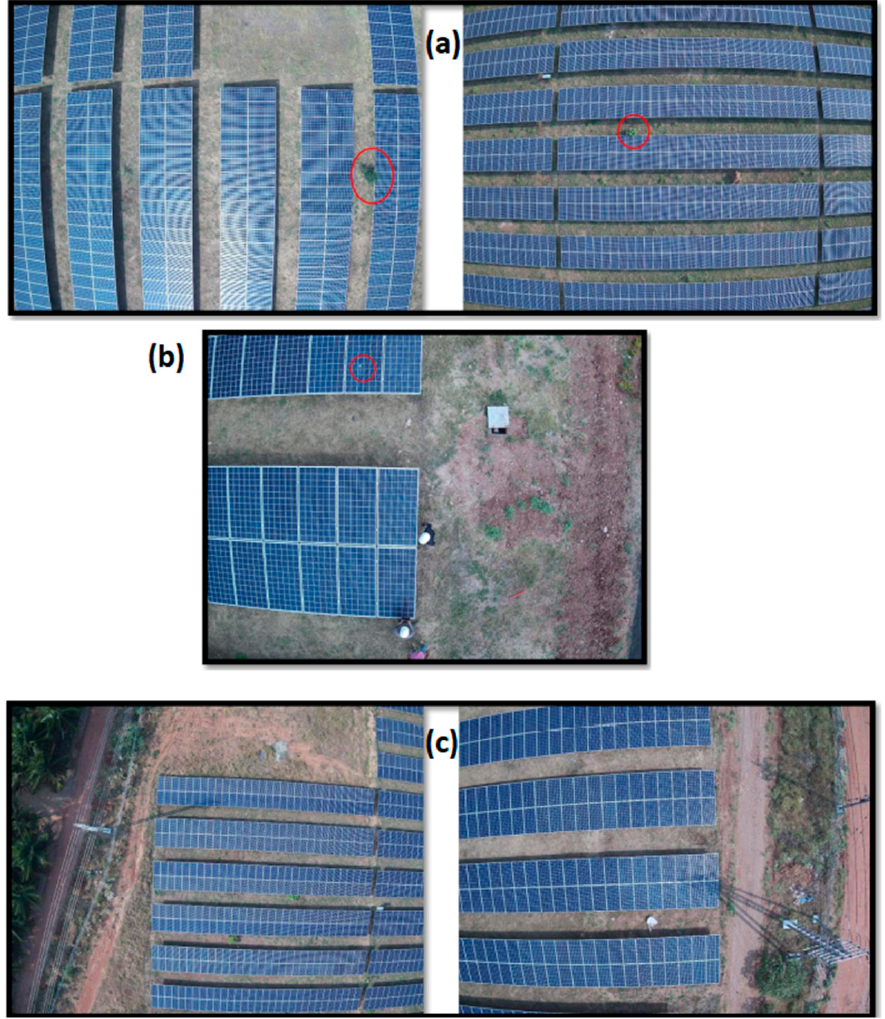
Figure 12. Some of the reasons detected for defective panels are related to external factors, such as the growing of plants ( a ), bird droppings ( b ), and shadows ( c ).